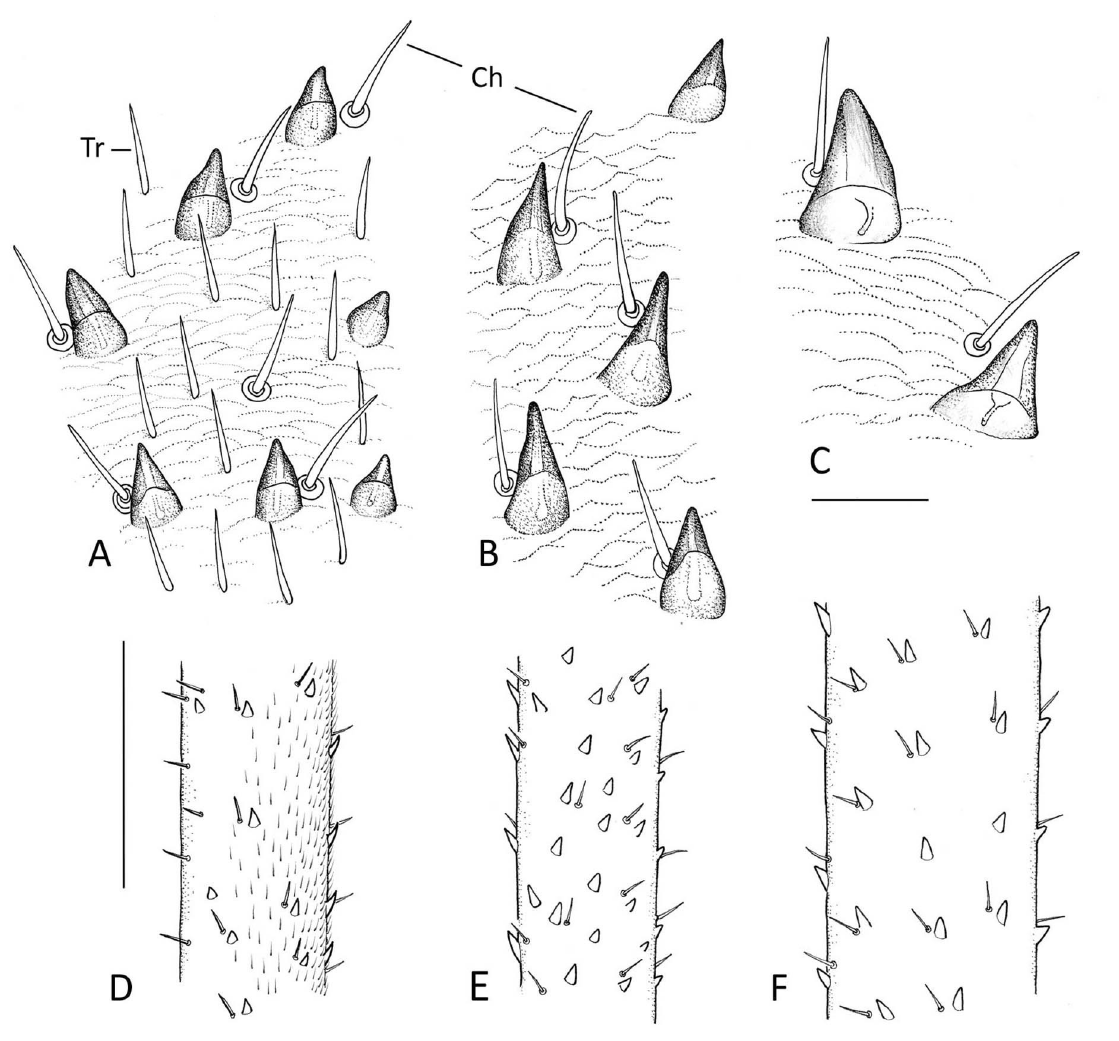
Fig. 3. Male femur I of three European species of Leiobuninae. A, D . Leiolima iberica gen. et sp. nov. (ZUPV 3330 at CHW). B, E . Nelima doriae (Canestrini, 1871) (from the Netherlands). C, F . Leiobunum rotundum (Latreille, 1798). A–C . Dorsal view. D–F . Lateral view (dorsal side on the right). Ch